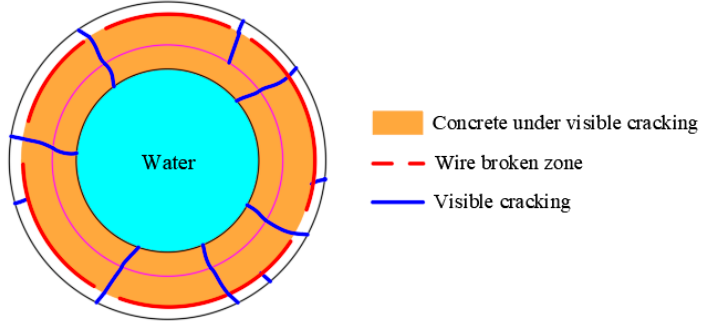
Figure 19. Wire broken stage.